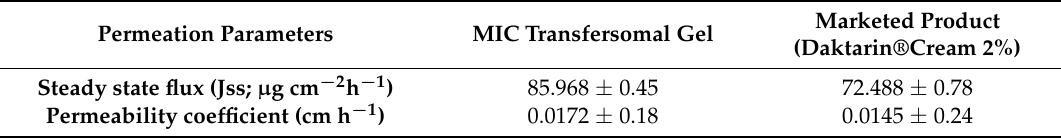
Table 9. Permeation parameters of MIC transfersomal gel in comparison to the marketed product (Daktarin®cream